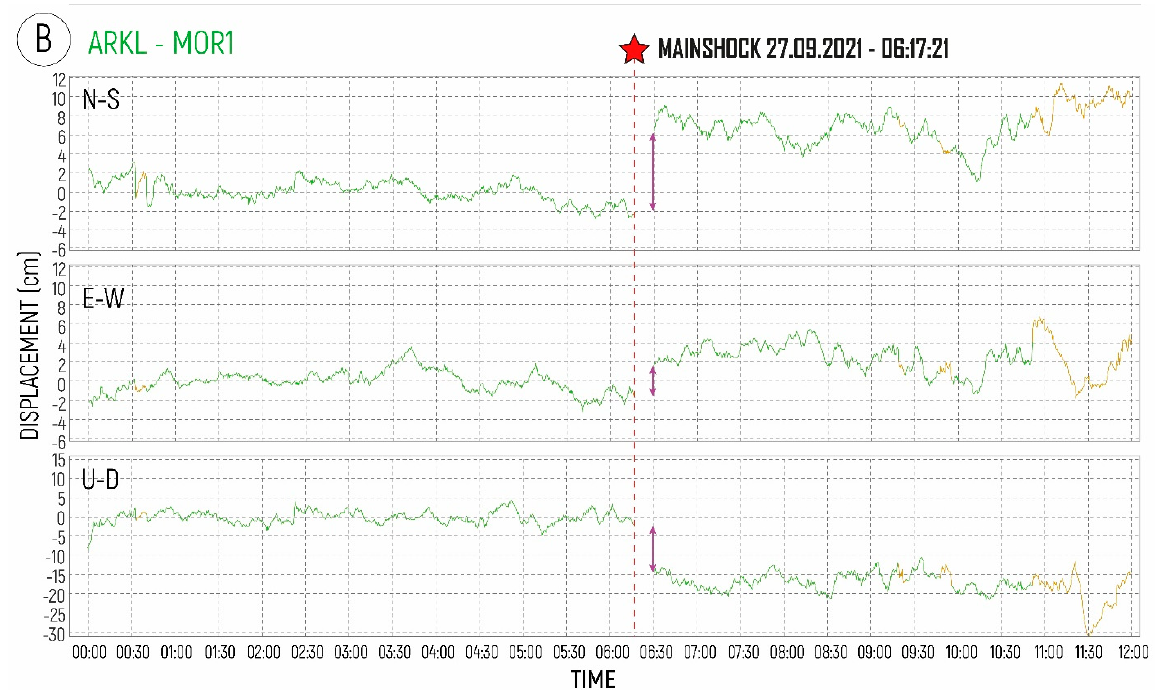
Figure 6. Time series during the day of the M L 5.8 event showing the co-seismic GNSS displacements in the three components of the ARKL station with respect to the HERA base ( A ) and with respect to the MOI1 base ( B ).